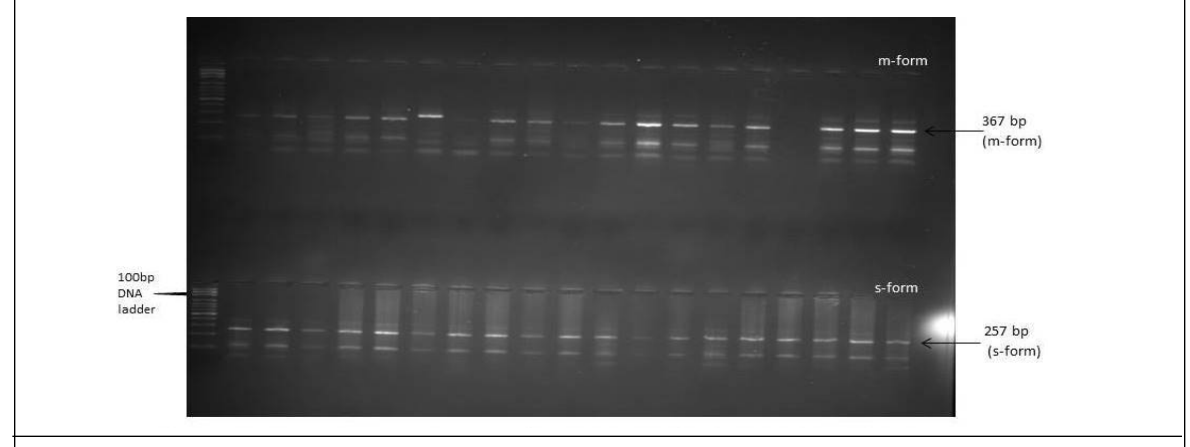
Figure 2: Amplified fragment using the species – specific assay for the identification of member of the An. gambiae s.s. Lane 1 lader (molecular marker), lane 2 negative control: lanes 3-20 test lanes of An. gambiae s.s. (m-form=367 bp and s-form=257